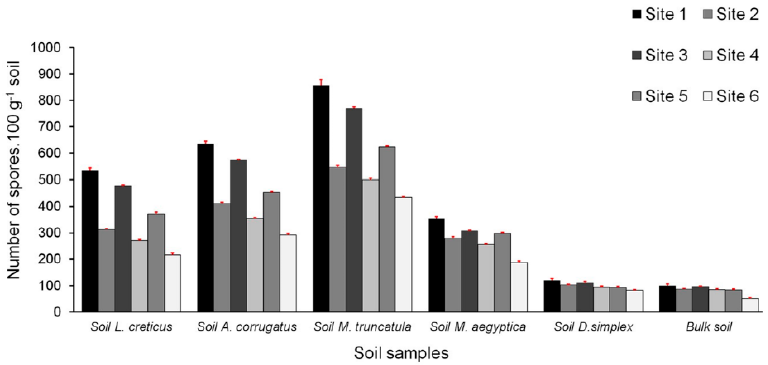
Figure 3. Distribution of AMF spores in the different rhizosphere soils. Data are reported as mean (±SE) of three replicates per sample.